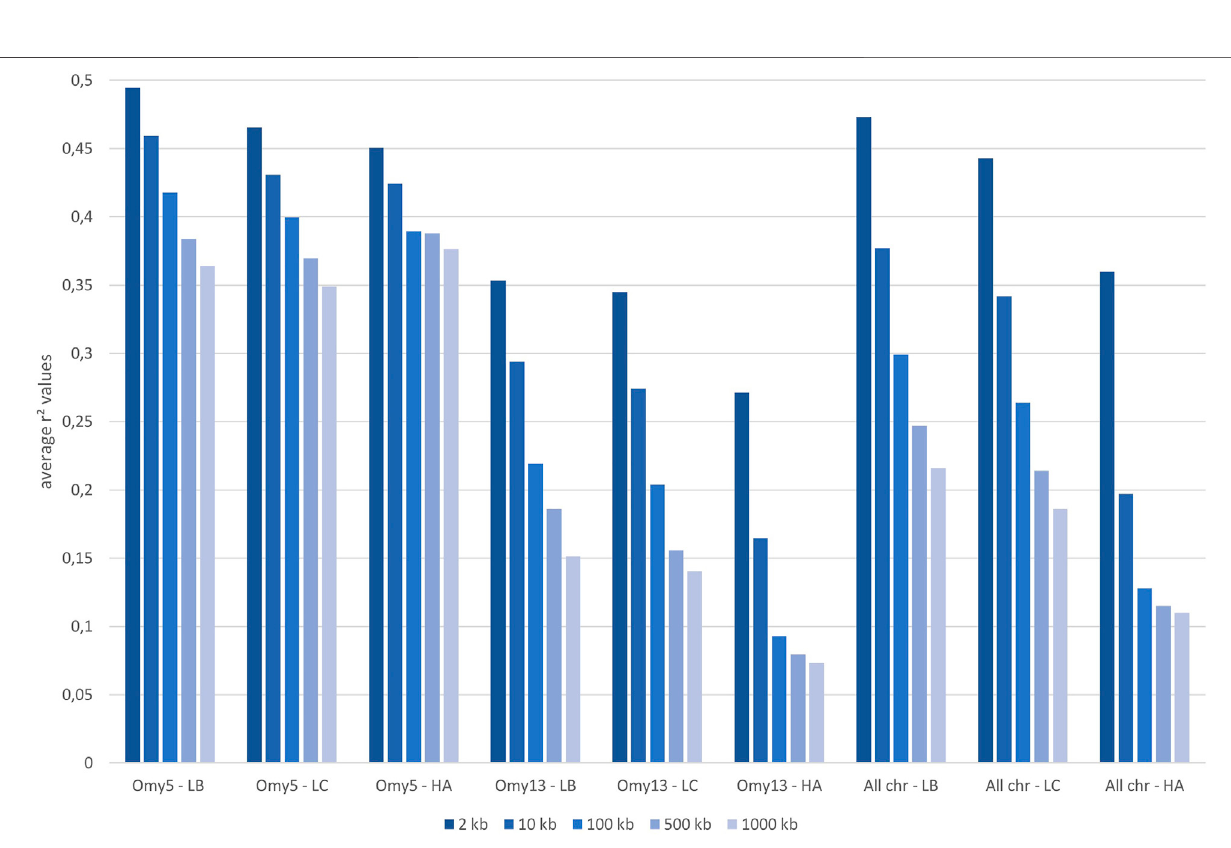
Frontiers in Genetics |